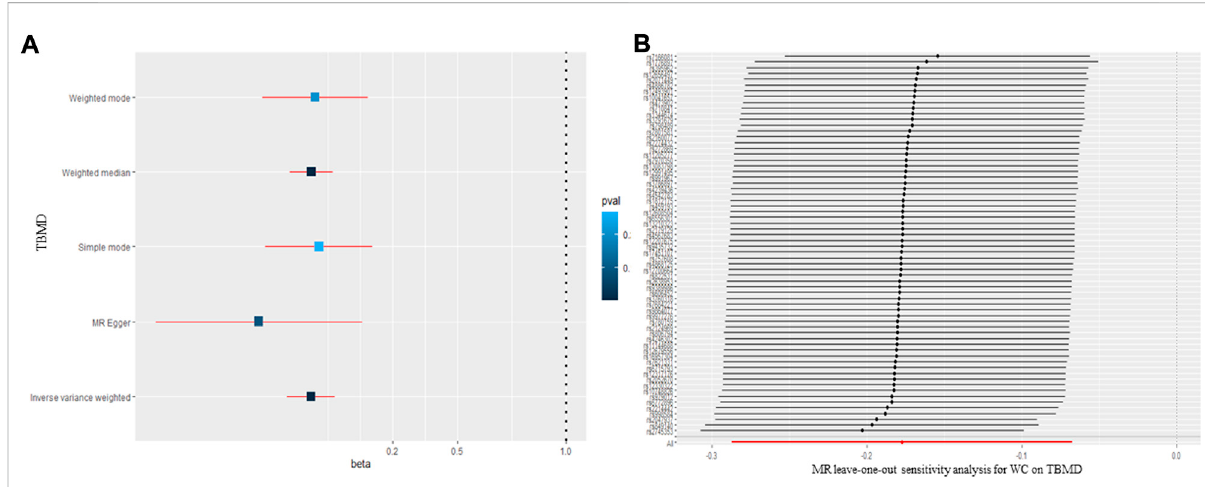
The causal effect of waist circumference on body mineral density (A) and (B) leave-one-out sensitivity analysis. TBMD: total bone mineral density; MR: Mendelian randomization; WC: waist